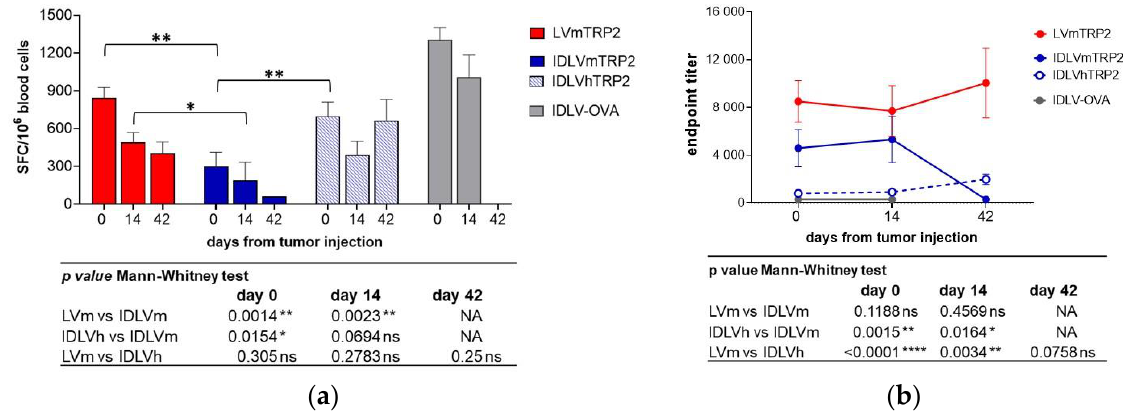
Figure 8. Kinetics of TRP2-specific immune responses in mice immunized with IDLV delivering either murine or human TRP2 and challenged with B16F10 tumor. C57BL/6 mice ( n = 9–11) immunized with vectors expressing TRP2, OVA, or left untreated were s.c. injected with 5 × 10 4 B16F10 cells/mouse after 30 days from immunization, as depicted in Figure 7a. ( a ) TRP2-specific T cell response was evaluated by IFNγ ELISPOT, measured at different time points in blood. Cells were collected and stimulated with H-2Kb restricted TRP2 9mer peptide (SVYDFFVWL). Data are expressed as mean spot forming cells (SFC) per 10 6 cells, bars represent standard error among animals from the same group. ( b ) Anti-mTRP2 IgG antibodies were analyzed in plasma of immunized animals by ELISA. Data are expressed as mean of endpoint titers and bars represent standard error among animals from the same group. Comparison among groups was evaluated using the Mann–Whitney test, as indicated by p values shown in the tables under the graphs. * p < 0.05; ** p < 0.01; **** p < 0.0001. NA: The comparison was not performed since only one animal from IDLVmTRP2 group was alive at day 42.